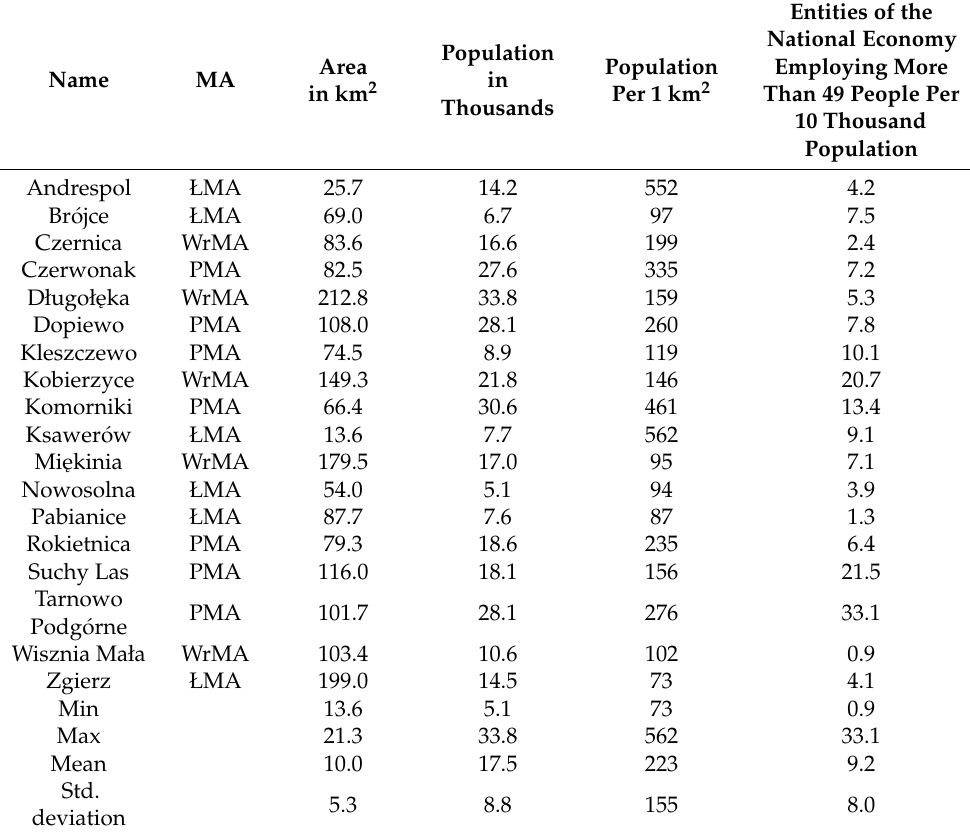
Table 2. Basic information about analyzed